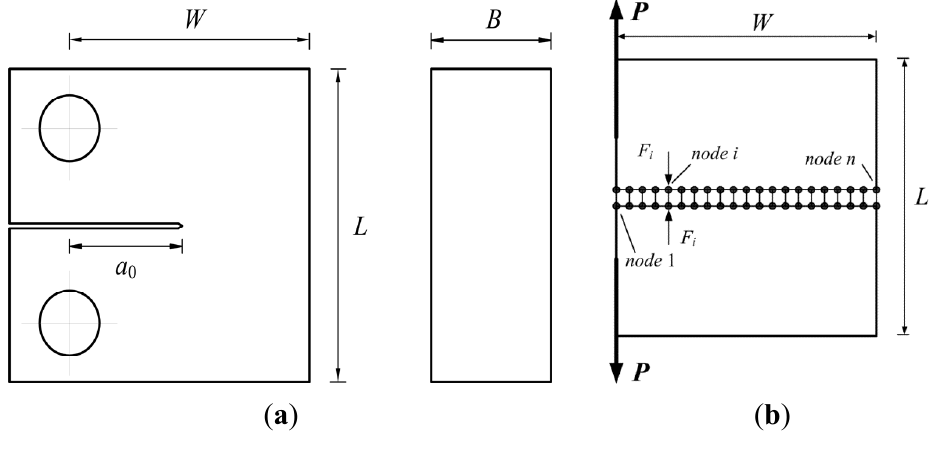
Figure 10. Compact Tension test: ( a ) geometry; and, ( b ) finite element nodes along the symmetry